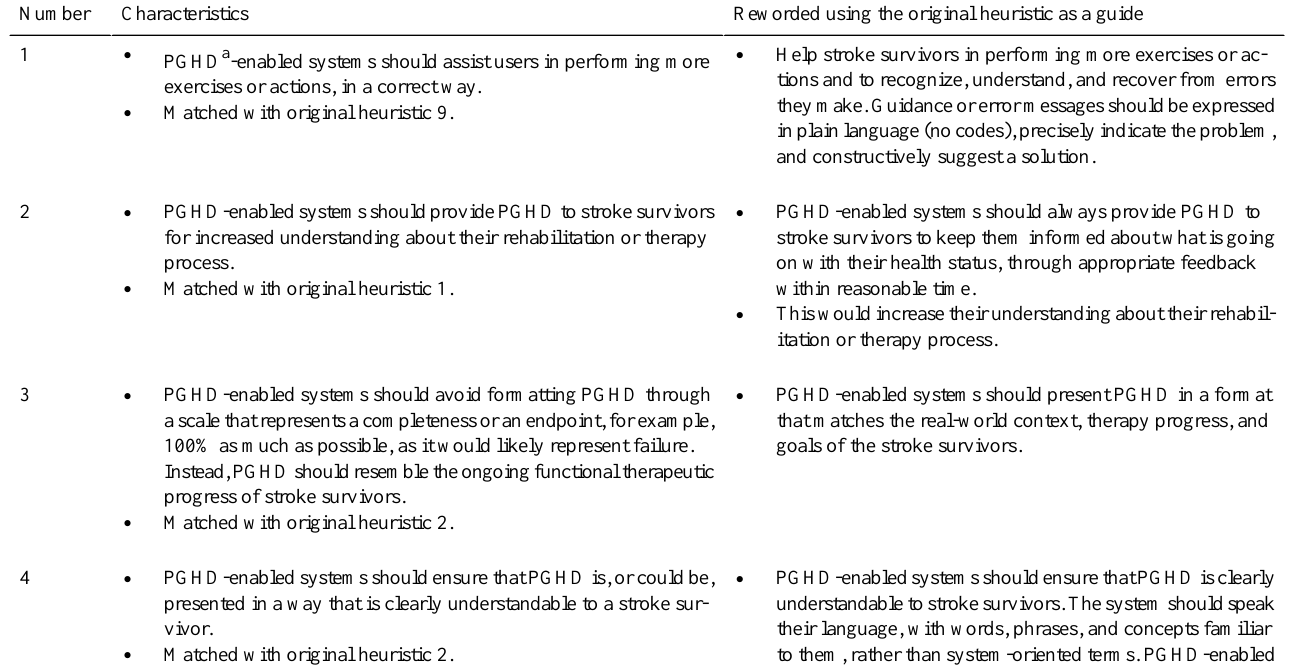
Table 3. Characteristics defined from the key concepts identified from steps 1 and 2—that match an original heuristic.